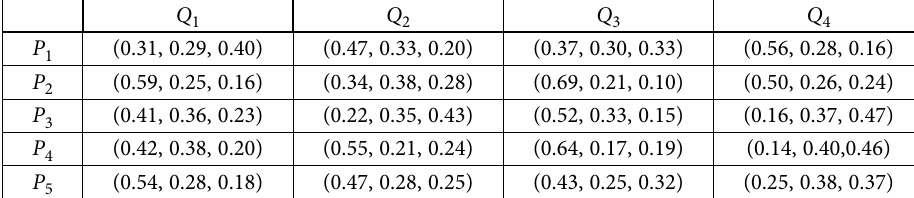
Table 2. Picture fuzzy evaluation information by DM 2 Q 1